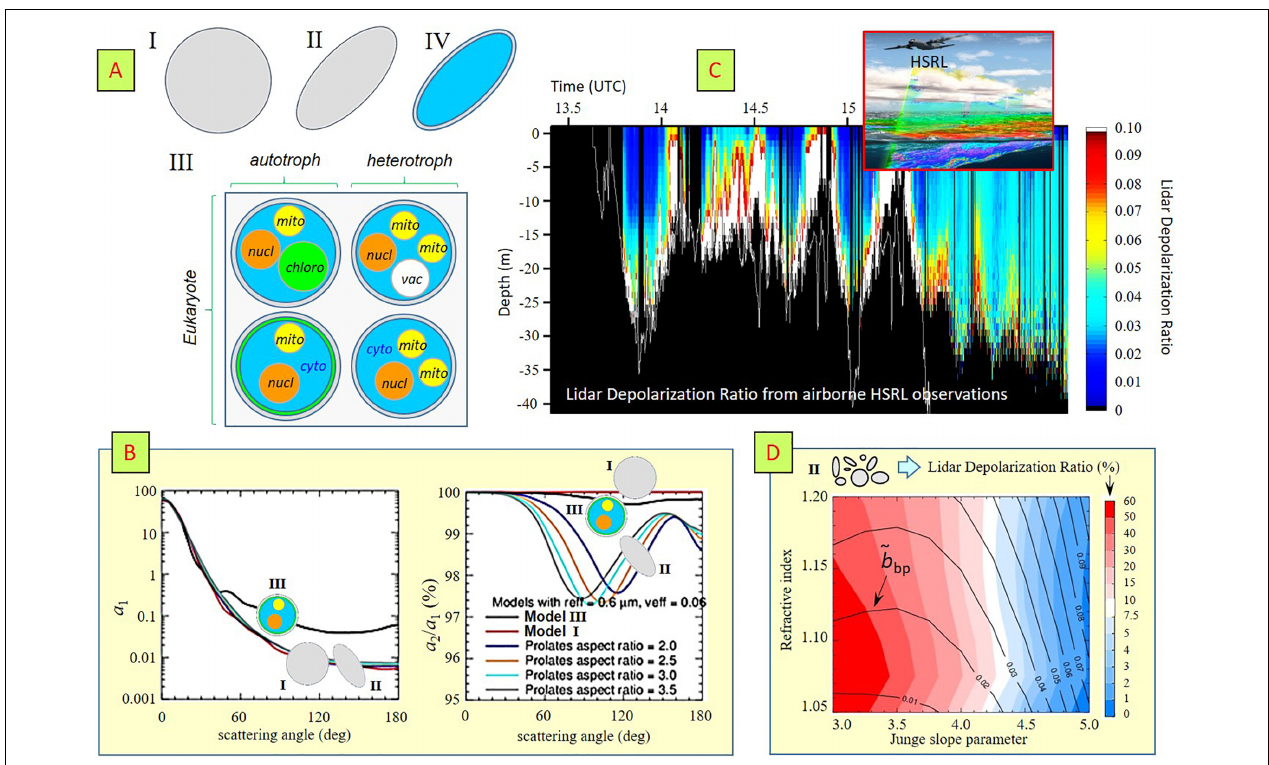
FIGURE 1 | (A) Particulate classes considered for plankton particles. Class I = spherical and homogeneous; Class II = non-spherical and homogeneous; Class III = spherical and inhomogeneous, Class IV = non-spherical and inhomogeneous. Class III and IV models contain a membrane wall and are filled with cytoplasm (“cyto”). Class III models contain one or more of the following organelles: chloroplast (“chloro”), mitochondria (“mito”), nucleus (“nucl”), vacuole (“vac”). (B) Scattering matrix element (1,1) (left diagram: a 1 ) and normalized scattering matrix element (2,2) (left diagram: a 2 / a 1 ) computed for Class I , II , and III particles. (C) Ocean depth profile of lidar depolarization ratio δ L example obtained by HSRL at λ = 532 nm during the NAAMES field campaign. The lower white curve marks the physical ocean bottom. (D) Lidar depolarization ratios and backscattering efficiencies computed at λ = 550 nm for randomly oriented Class II particles as a function of Junge size distribution exponent and refractive index.